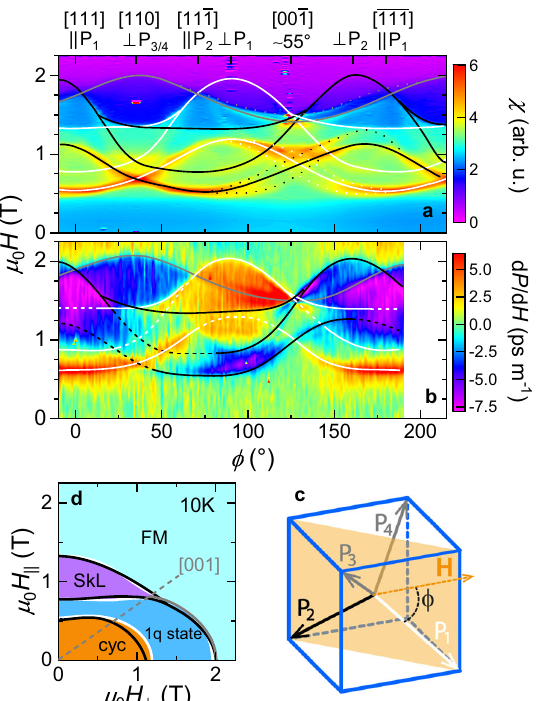
Fig. 3 Angular dependence of the magnetic phase diagram at 10 K. Angular dependence of the magnetic susceptibility and magnetocurrent measured at 10 K are displayed in panel a and b , respectively. Panel c illustrates the orientations of the four polar axes (P 1 − 4 ) and the plane where the magnetic fi eld was rotated by angle ϕ . The lines represent the magnetic phase boundaries for the different domains (white: P 1 , black: P 2 , grey: P 3 and P 4 ). Dotted lines in panel ( a ) represent a splitting of the phase boundary, while dashed lines in panel ( b ) indicate regions where the anomalies could not unambiguously be identi fi ed. The magnetic phase diagram constructed based on the angular dependence of these anomalies at 10 K is shown in panel d . cyc, SkL and 1q state respectively label the cycloidal, skyrmion lattice and a modulated phase described by a single q-vector. H ∥ and H ⊥ are fi eld components parallel and perpendicular to the polar axis, respectively. magnetic correlation length. To make our analysis more quanti- tative the fi eld dependence of the scattering intensity and the average length of the q -vectors are plotted in Fig. 4c, d, respectively, in comparison with the susceptibility shown in Fig. 4b. The grey and red curves are obtained by fi tting a Gaussian peak on the azimuthally averaged scattering intensity around the h 110 i and h 112 i -type directions highlighted by grey and red sectors in Fig. 4a. The phase transitions are marked by clear anomalies of the scattering parameters. As we have demonstrated above, only the P 1 domain, responsible for the red ring in Figs. 1d and 2, scatters neutrons into the red sections whereas all domains contribute to the intensity detected in the grey regions. Remarkably, our measurements evidence that modulated magnetic structures are extremely robust against a magnetic fi eld, i.e., they extend up to 1.3 and 1.8 T for fi elds parallel to and inclined at 71 ∘ from the polar axis, respectively. Such exceptional stability of modulated bulk phases has been observed so far only in centrosymmetric materials, hosting nearly atomic-scale skyrmions due to exchange frustration 45,46 . As the modulated phases are expected to be stable up to a critical fi eld of order H FM ∝ D 2 / J , this fi nding